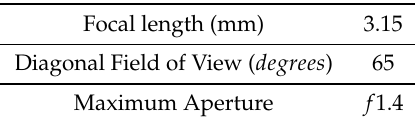
Table 2. Camera lens